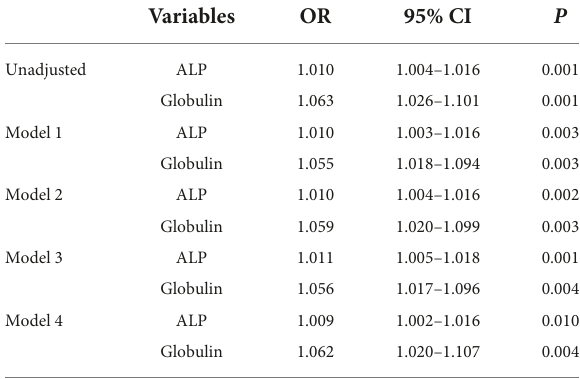
TABLE 5 Logistic regression analysis of the relationship between alkaline phosphatase (ALP) and globulin with poor